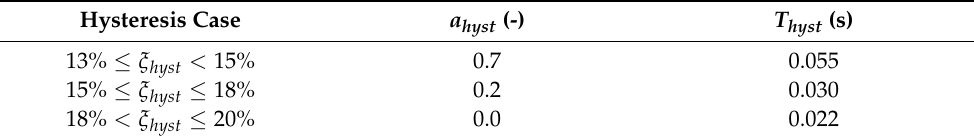
Table 2. Calibrated parameters for the proposed modified-N2 (MN2) equation [44].